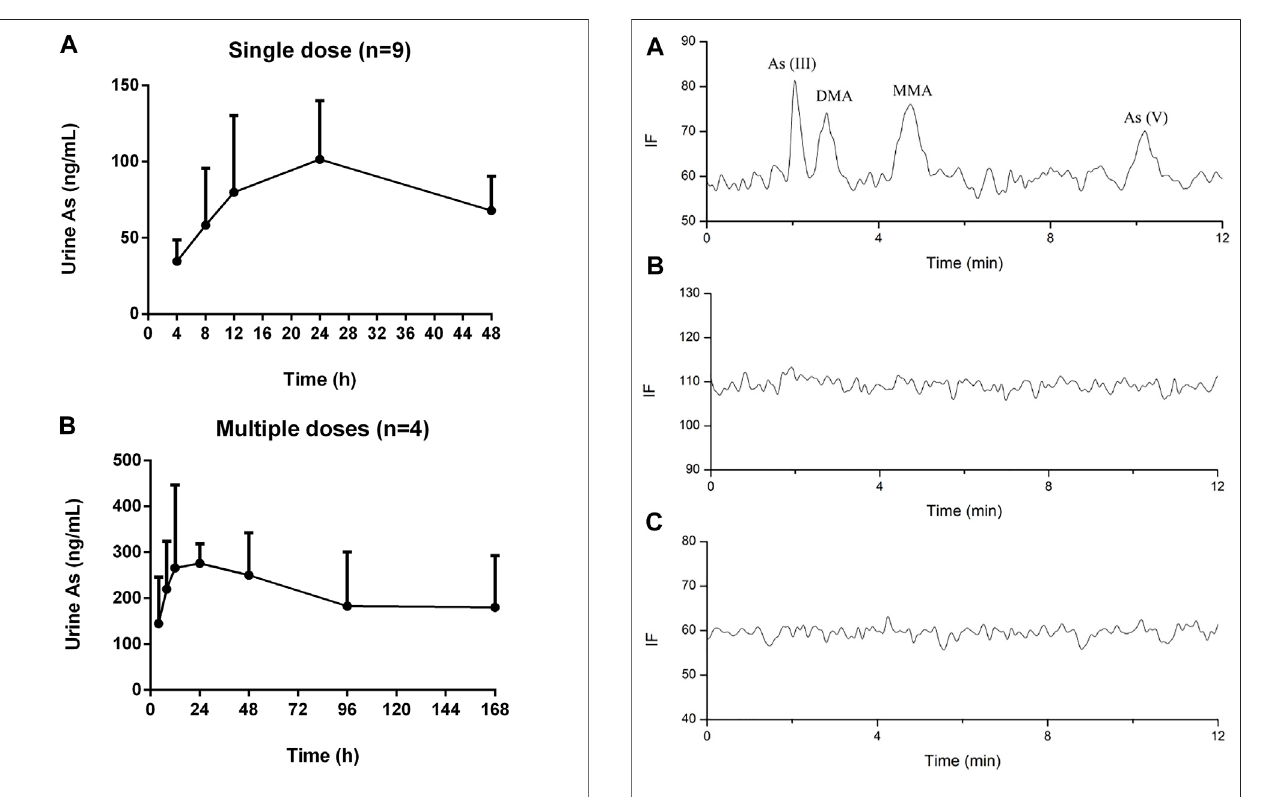
FIGURE 3 | Representative HPLC-HG-AFS chromatograms of arsenic species in human plasma. (A) . blank spiked with arsenic species of 3.125 ng; (B) . sample after single oral administration; (C) . sample after multiple oral